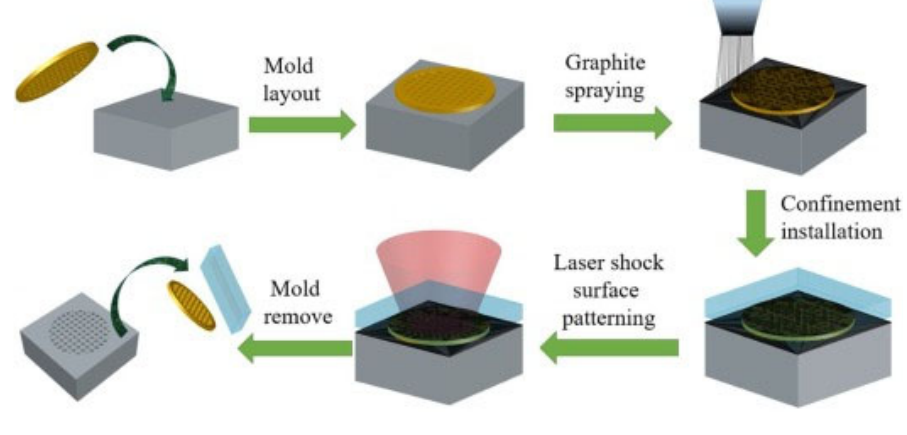
Figure 14. Schematic of LSSP [9].